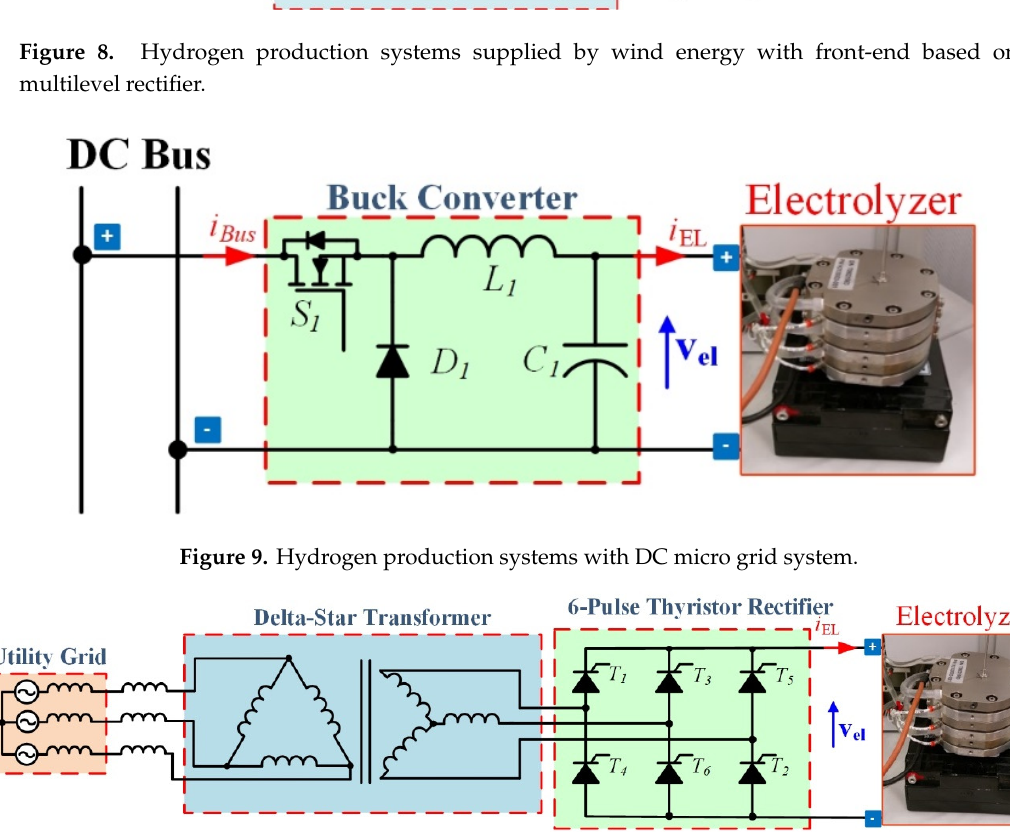
Figure 10. Hydrogen production systems connected to the power grid.